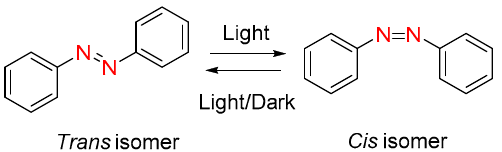
Figure 18. Photoisomerization process of azobenzene under light irradiation or in dark condition.